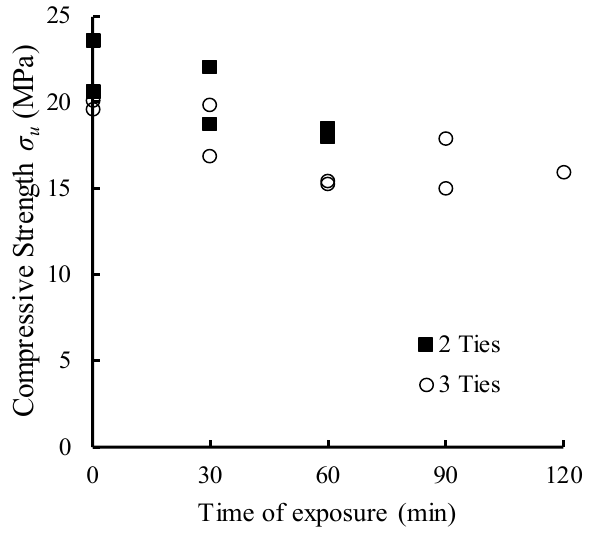
Figure 9. Strength of stub columns with two or three lateral ties for different times of